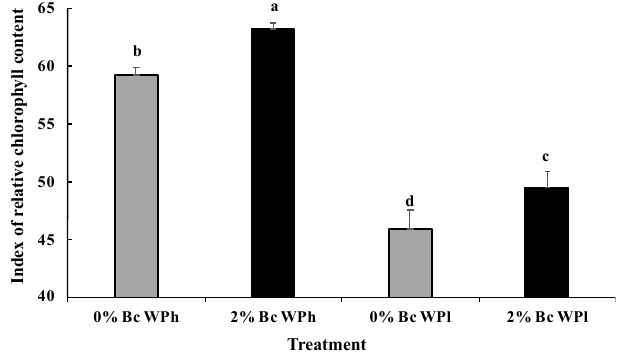
Figure 4. Chlorophyll concentration in Medicago ciliaris after 3 weeks of drought treatment. Values represent mean ± SE ( n = 5) and the different letters a to d indicate significant differences between the treatments. Low soil water potential (WPl), high soil water potential (WPh), Biochar (Bc). The development of the protein content was nearly reciprocal to the chlorophyll content (Figures 4 and 5). Drought led to a significant increase of the protein content and biochar to a non-significant decrease (in the mean).